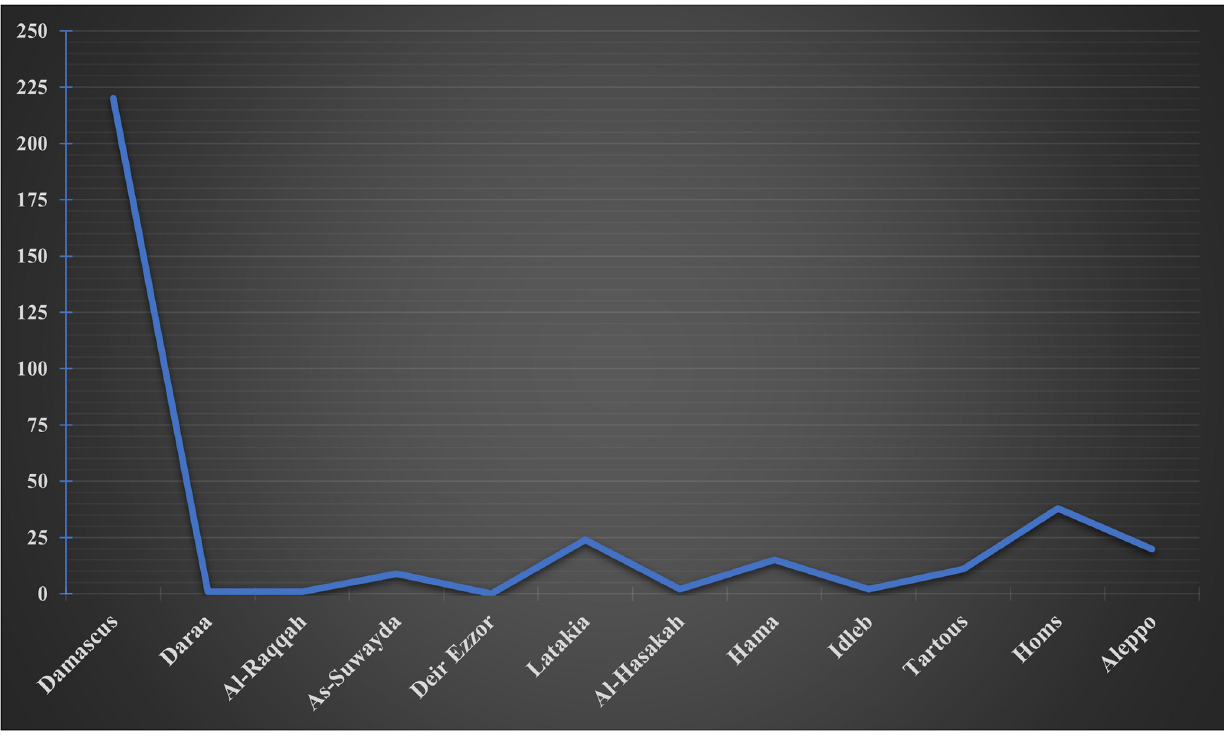
Fig 2. Current tobacco smoking among the participants based on the governorate of residence in Syria (frequency